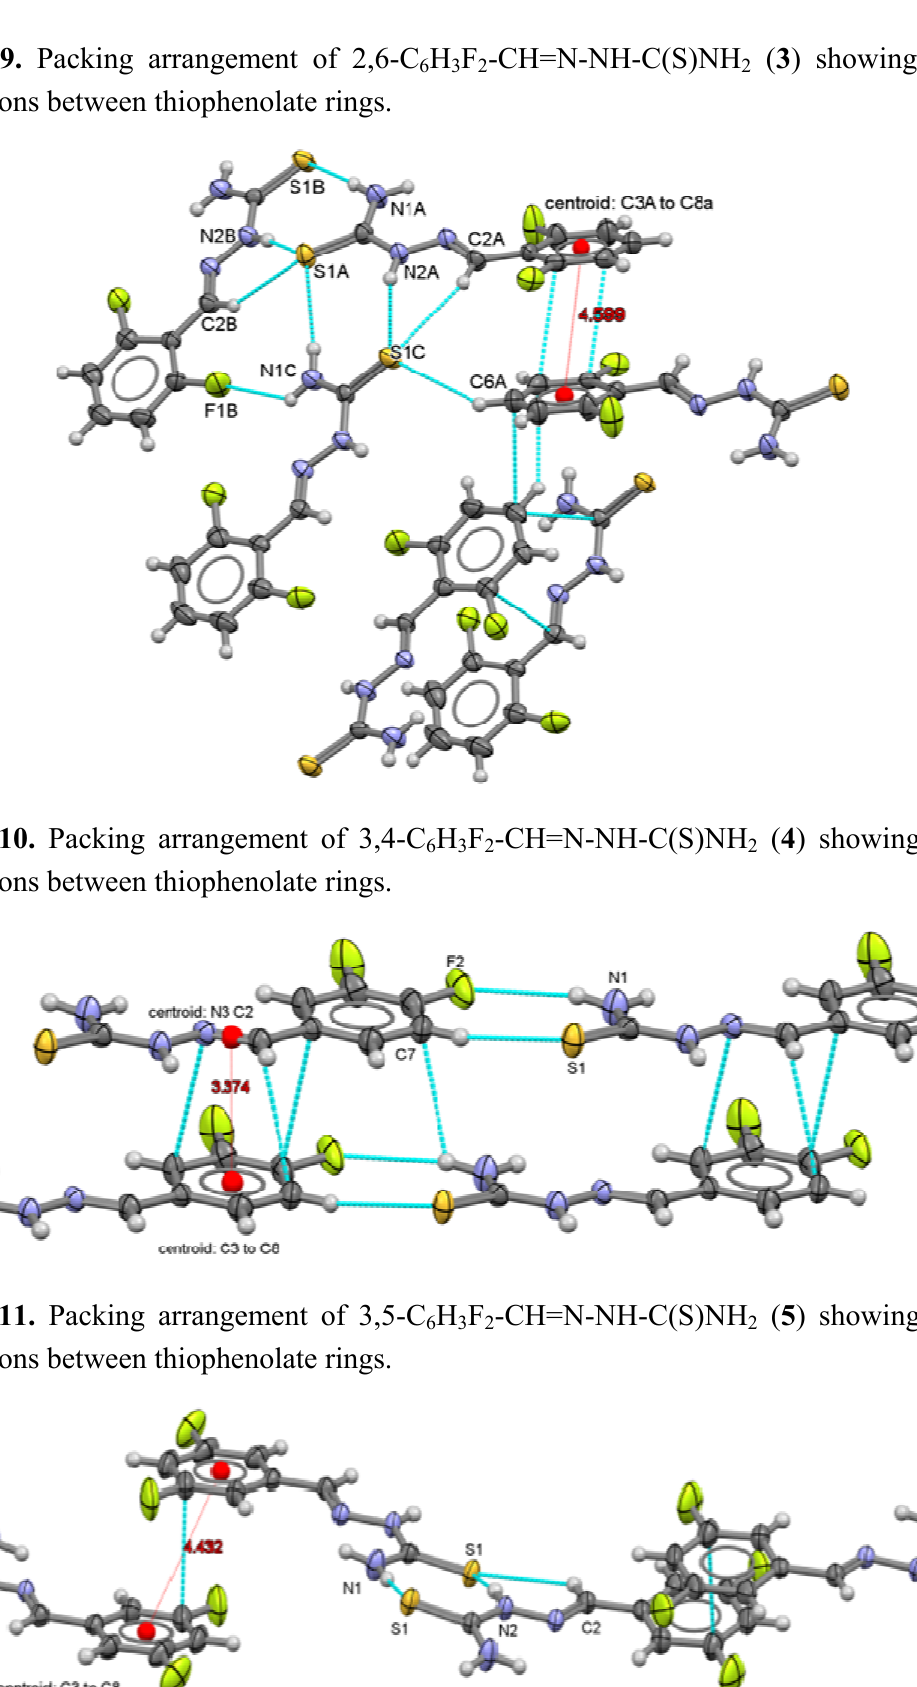
H F -CH=N-NH-C(S)NH 6 3 2